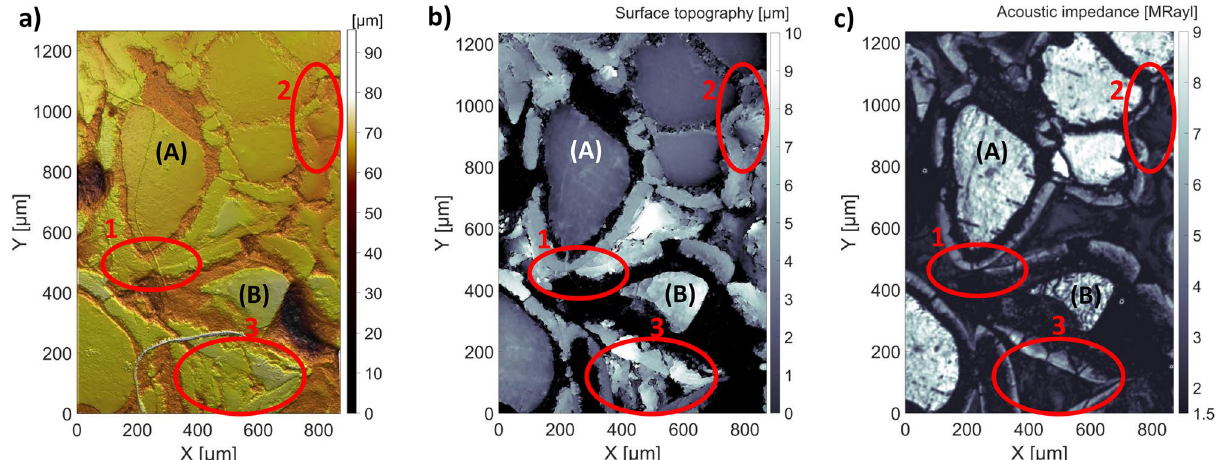
Figure 2. Comparison of ( a ) SWLI image, ( b ) CESAM topography map, and ( c ) CESAM acoustic impedance map to determine regions-of-interest (ROIs) related to bone formation. Three areas (Area 1–3), showing ambiguous features in the topography maps, are indicated in all images. The acoustic impedance information in these regions assists in determining ROIs. Glass granules (A) and (B) are